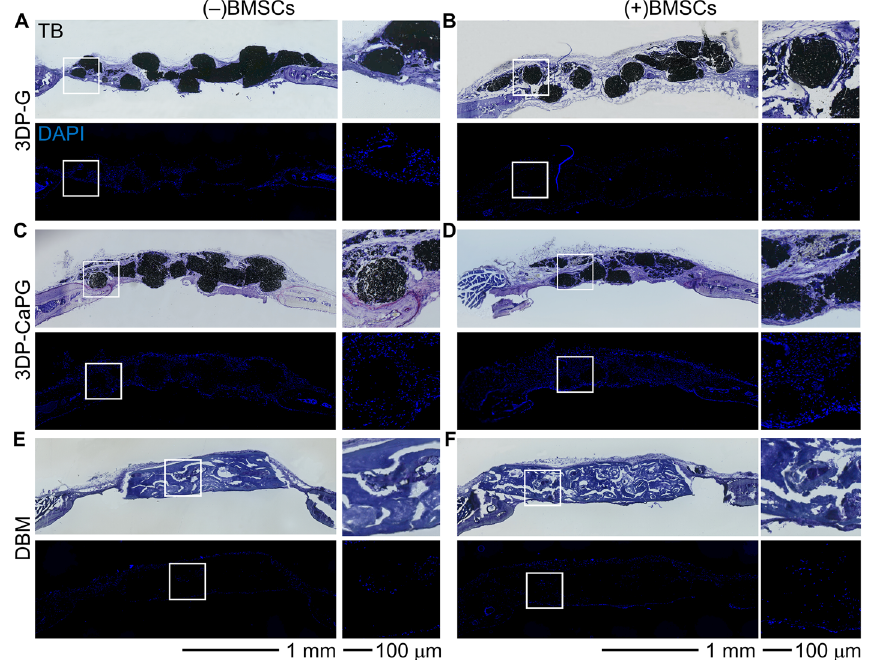
Figure 4. Biocompatibility of the matrices in a mouse calvarial defect model. Histology images of calvarial defects implanted with 3DP-G, 3DP-CaPG, and DBM that are stained with toluidine blue (TB) and DAPI (cell nuclei,